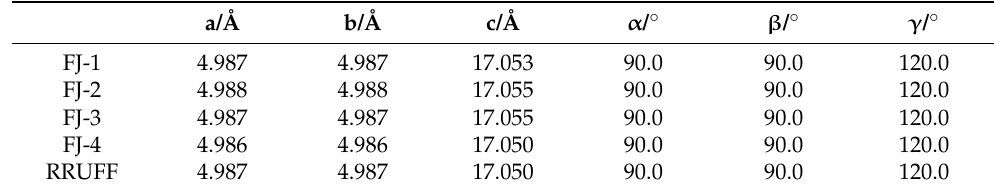
Table 1. Unit cell parameter values of four Fujian calcite samples and RRUFF standard data are listed for